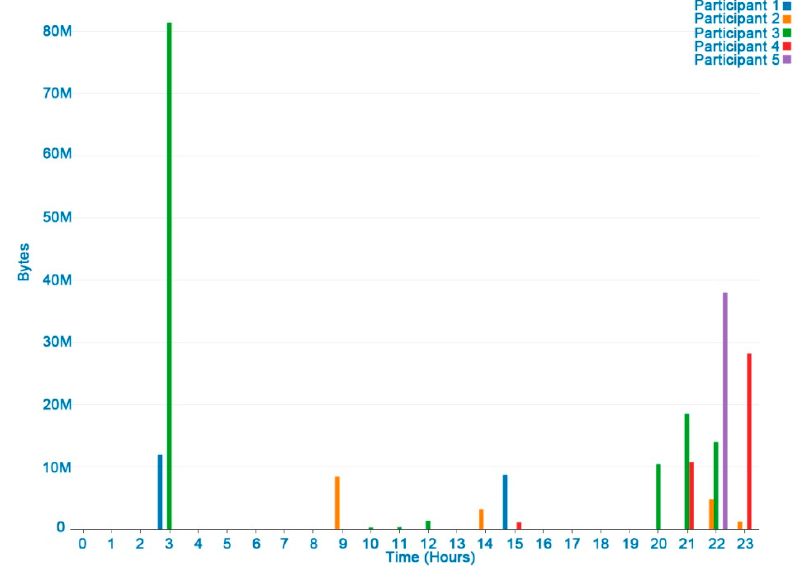
Figure 8. Traffic (Mb) in a day.